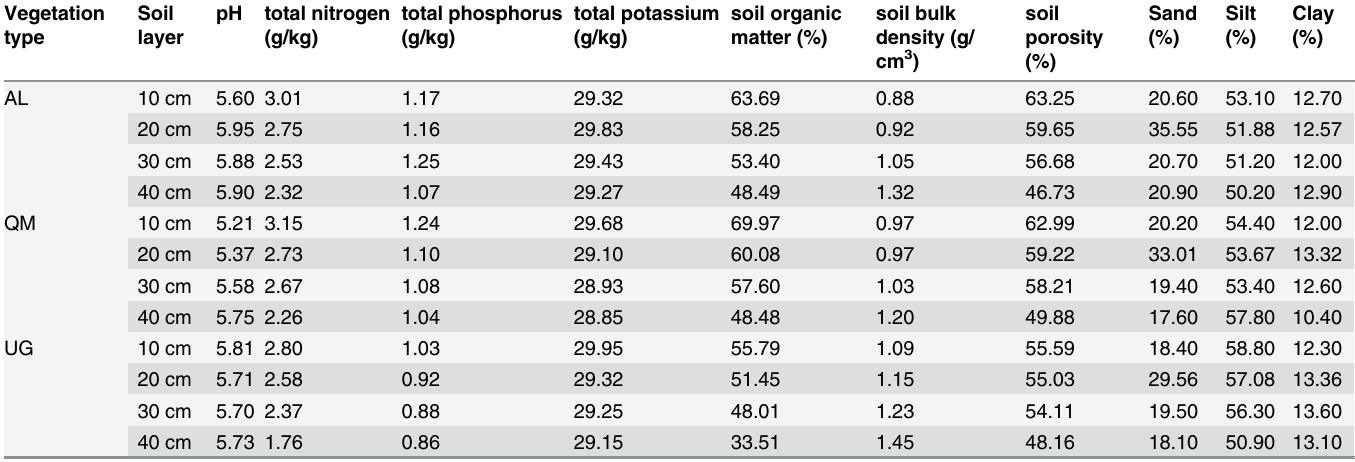
Table 5. Soil characteristics of the three vegetation types. Vegetation Soil type